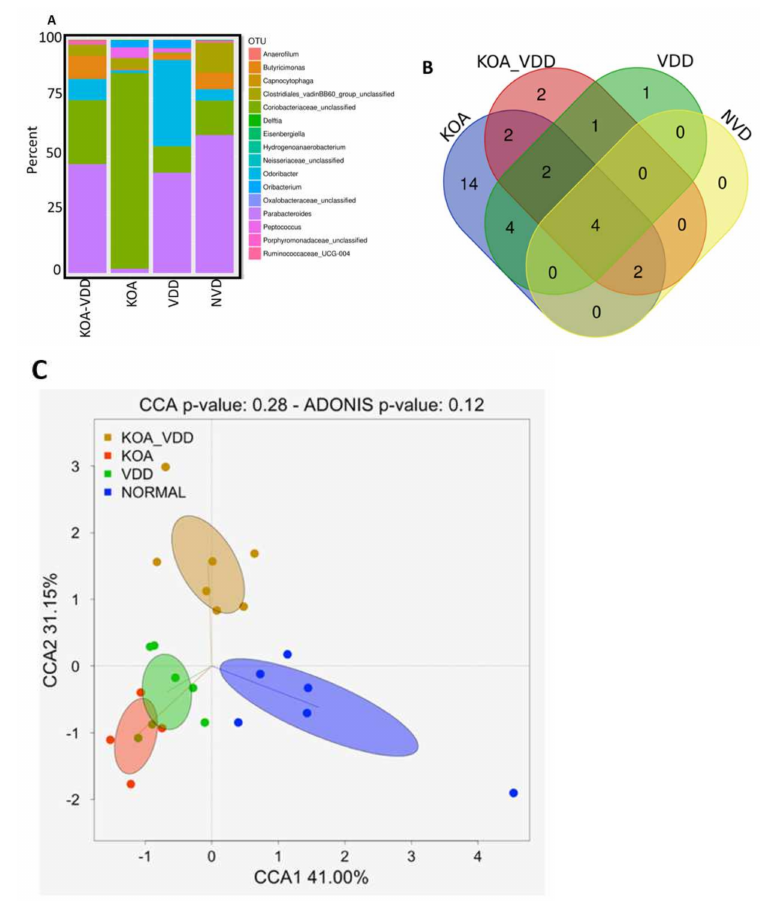
Figure 1. Gut microbiome profile: ( A ) Operational Taxonomic Units (OTU) abundance was deter- mined in stool samples collected across 4 study groups depicted in the bar chart; ( B ) Venn diagram with filtered OTUs excluding counts less than 50 OTUs; ( C ) canonical correspondence analysis (CCA) was performed to study the beta diversity between stool microbiome in Knee osteoarthritis (KOA)_vitamin D deficiency (VDD), KOA, VDD and Normal